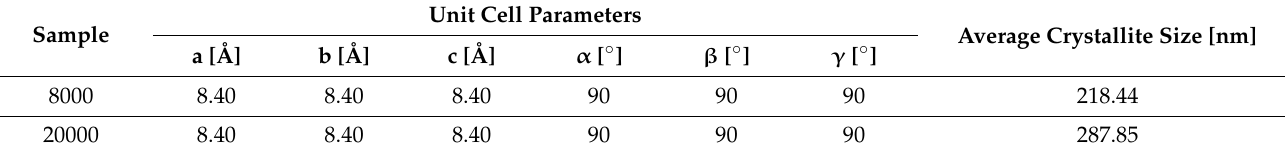
Figure 2. Diffractograms of the obtained magnetite microspheres. Table 2. The cell parameters and the average crystallite sizes for the two types of magnetite micro-